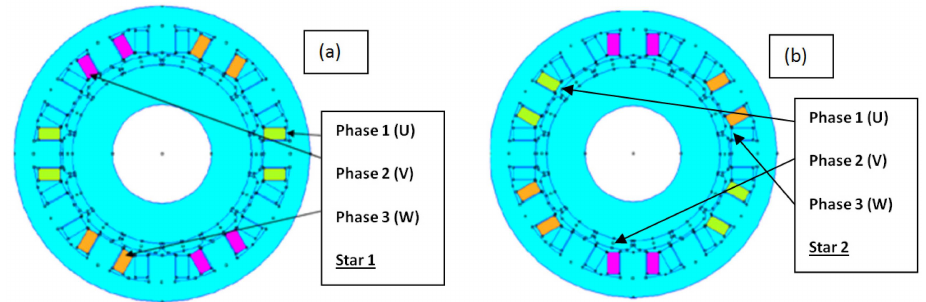
Figure 10. The layout of windings associated to the structure having 12 slots and 14 poles. It can be split into two three-phase stars ( a , b ) which are shifted, electrically, by 30 ˝ . Thereafter, this machine is a true conventional double-star machine.